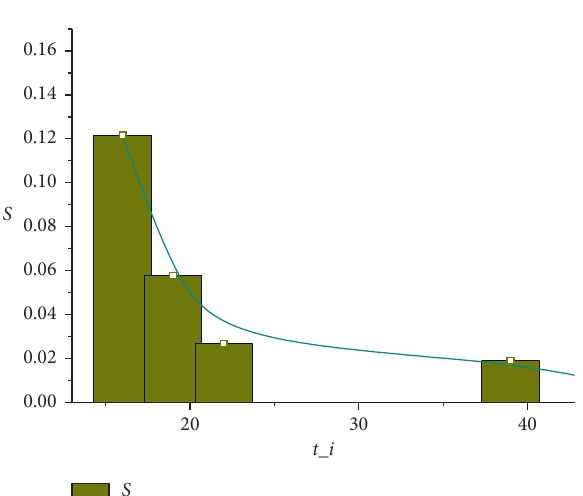
Figure 4: Revenue versus cycle number. Figure